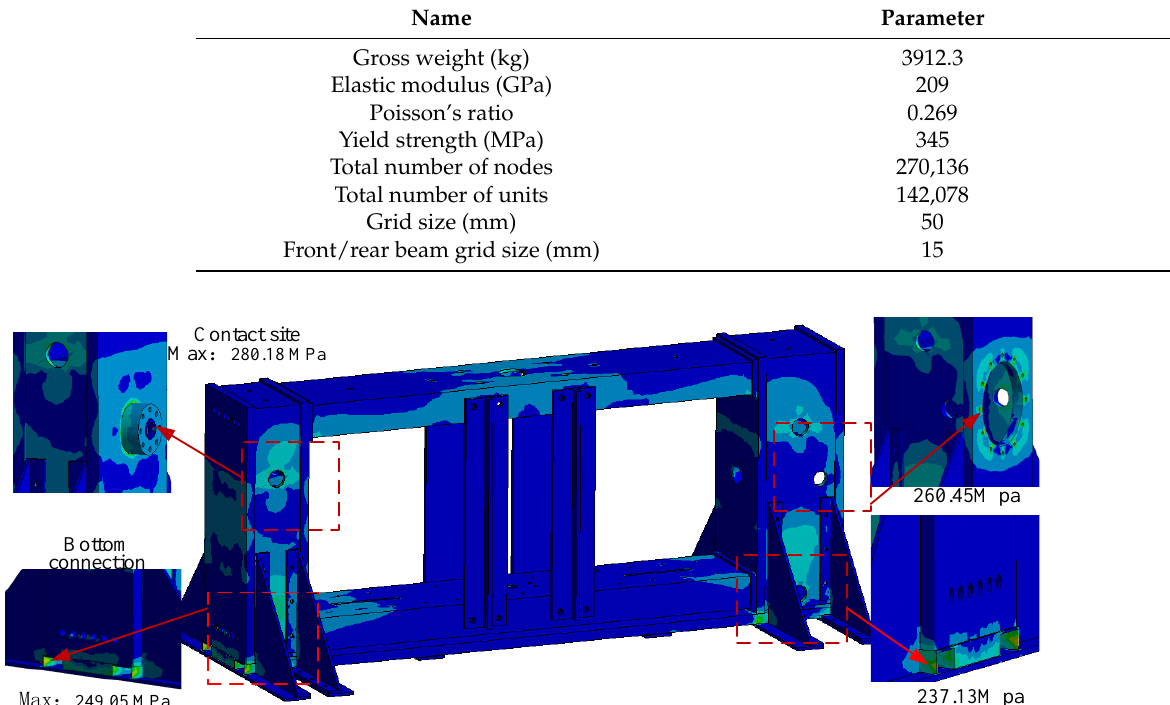
Table 2. Simulation parameters.